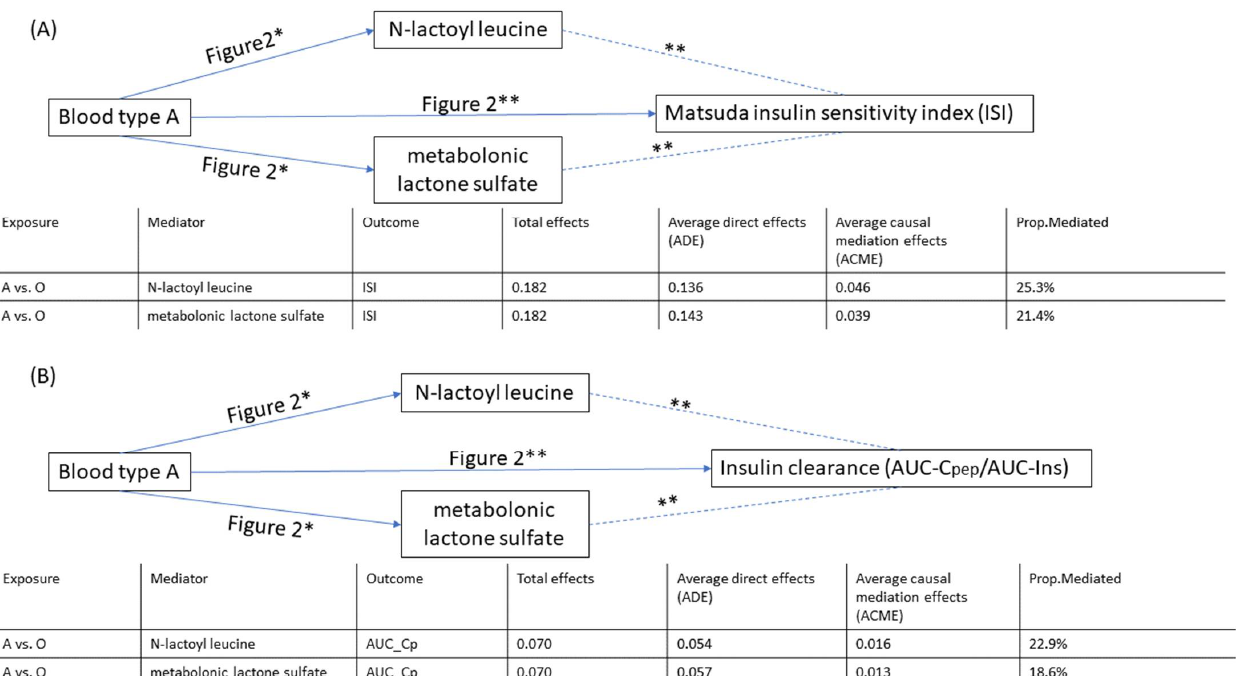
Figure 3. Mediation analysis between blood type A and insulin-related traits. ( A ) illustration of mediation analysis between blood type A and ISI; ( B ) illustration of mediation analysis between blood type A and insulin clearance. * marginally significant with a p -value < 0.05. ** Bonferroni corrected p -value < 0.0024 (0.05/21) for metabolites.